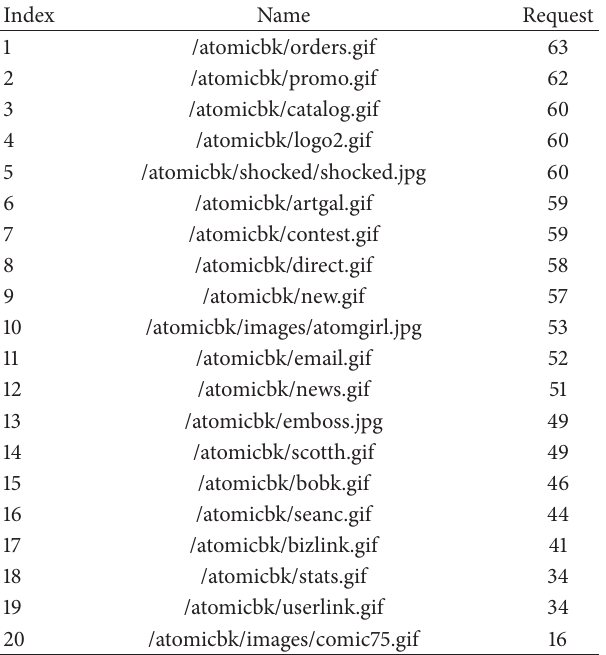
Table 1: The frequency of request to the embedded